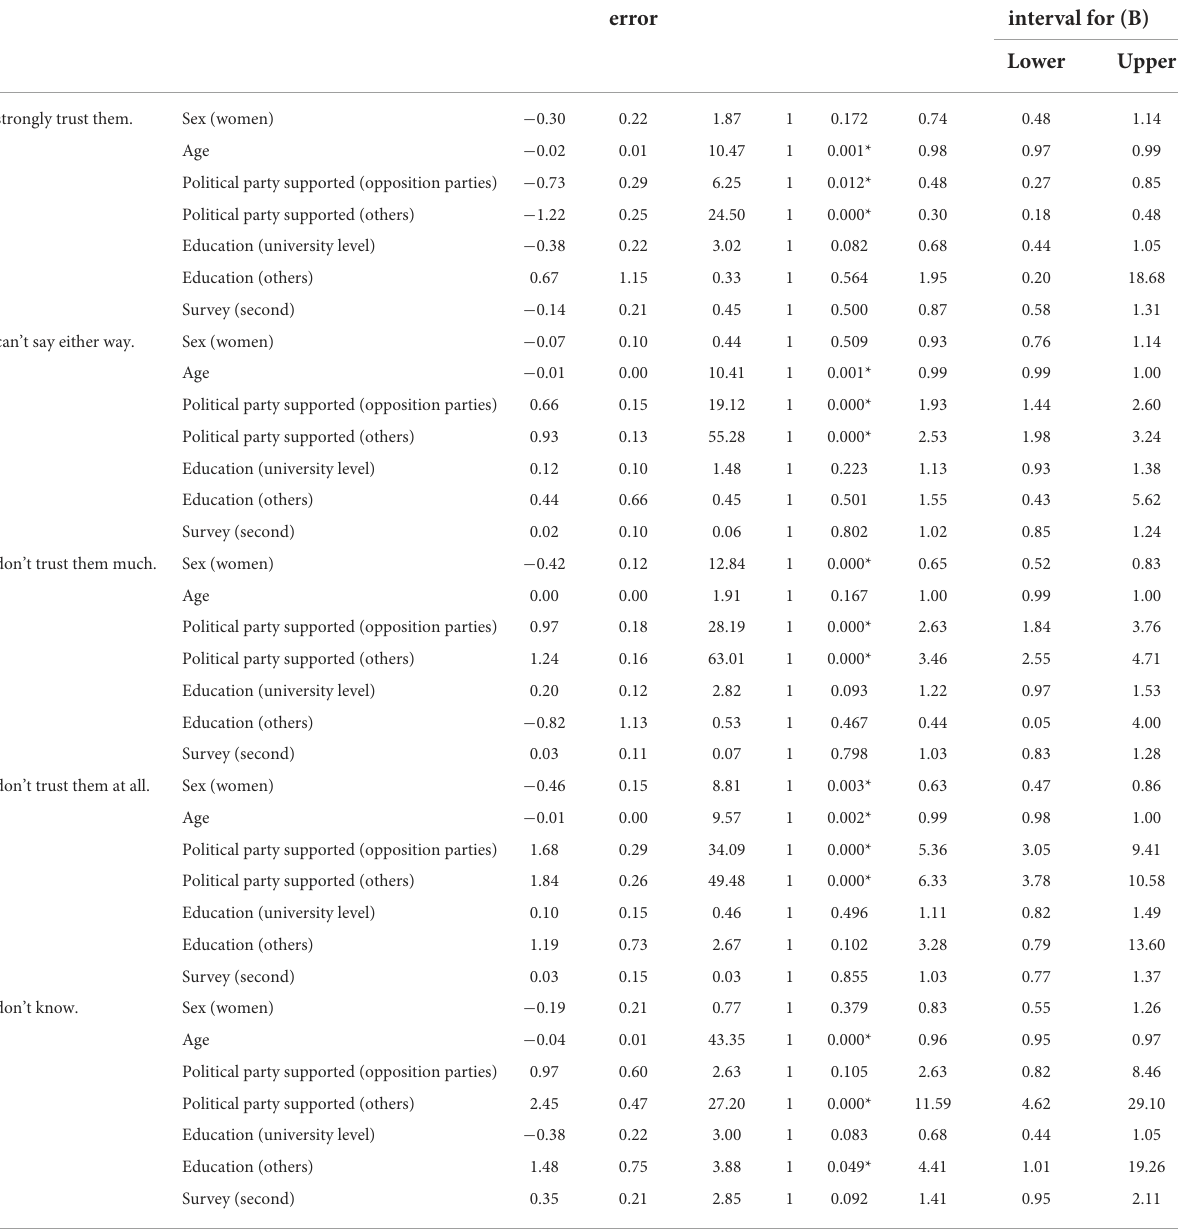
TABLE 2 Statistical analysis of trust in COVID-19